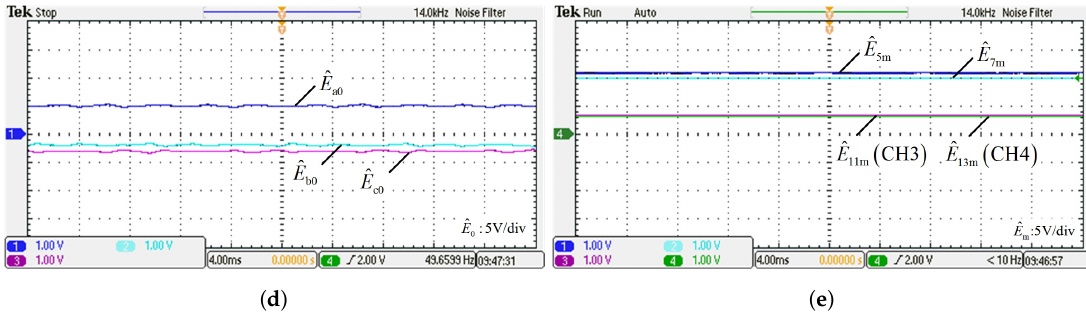
Figure 11. Experimental steady results when three-phase unbalanced voltages contain DC offsets and higher harmonics. The waveforms of ( a ) e abc ; ( b ) ˆ f , ˆ ϕ ba , and ˆ ϕ ca ; ( c ) ˆ e abc and ˆ θ a ; ( d ) ˆ E abc0 ; ( e ) ˆ E 5m , ˆ E 7m , ˆ E ˆ E 11m , and 13m .